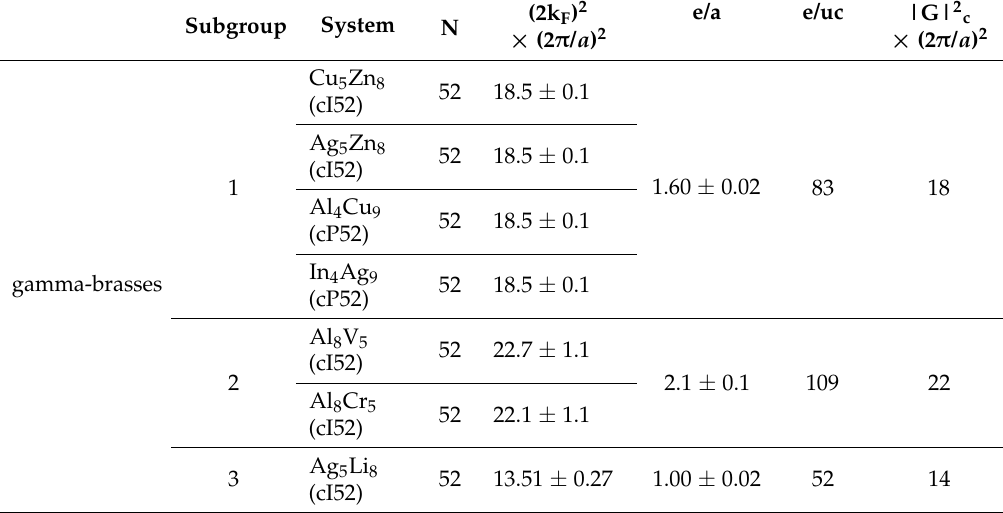
Table 3. Hume-Rothery electron concentration rule for gamma-brasses (cI52 or